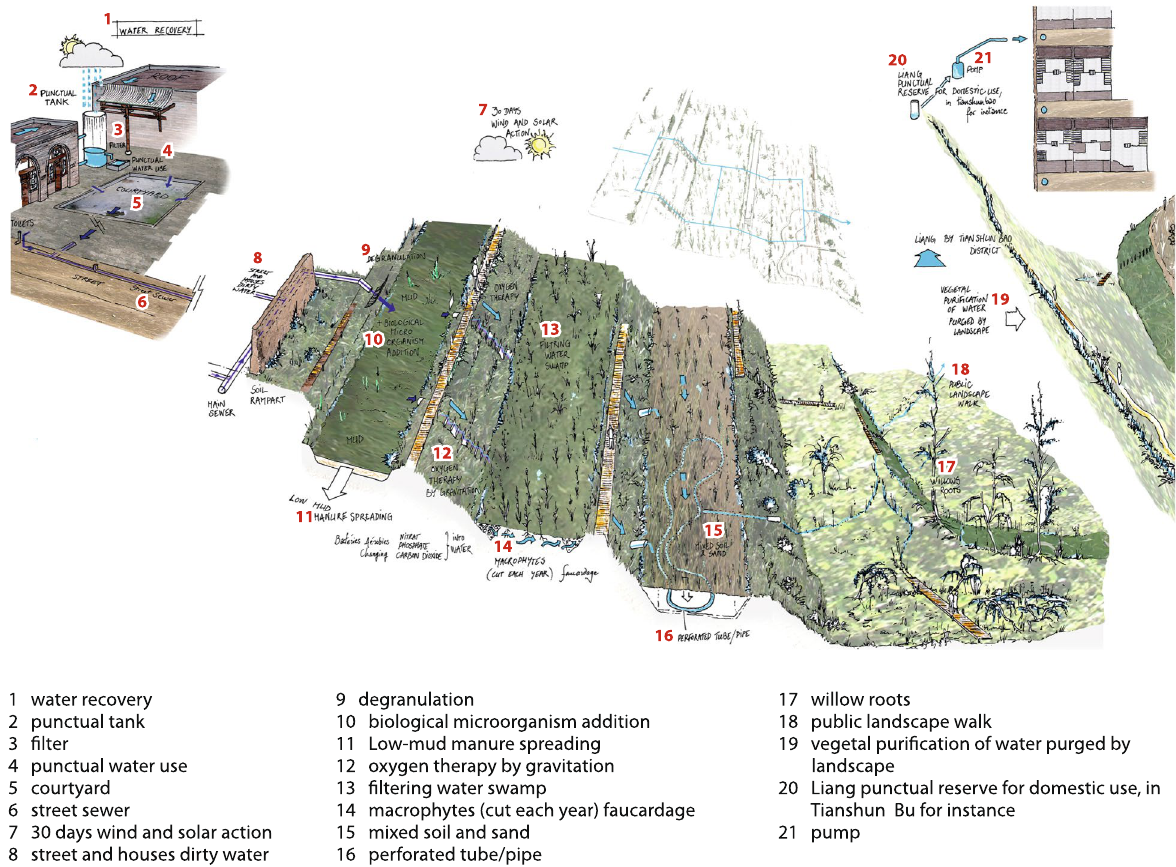
Fig. 19 Rainwater collection system in the region, from settlement to building (Source: Tongji University and Ecole de Chaillot